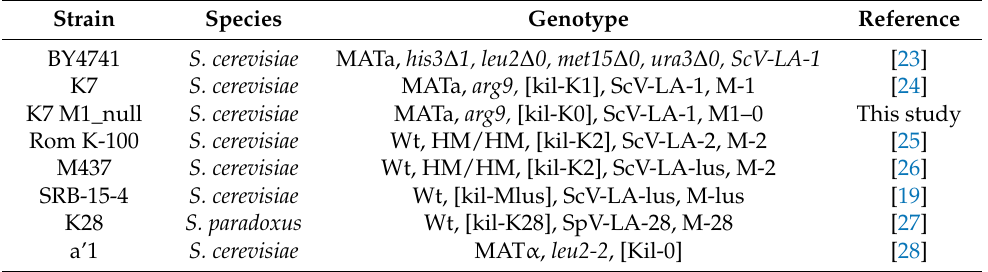
Table 1. Yeast strains used in this